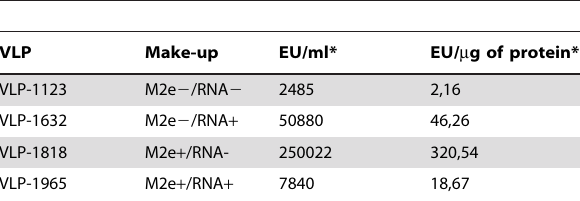
Table 1. Characteristics of virus-like particles used in this